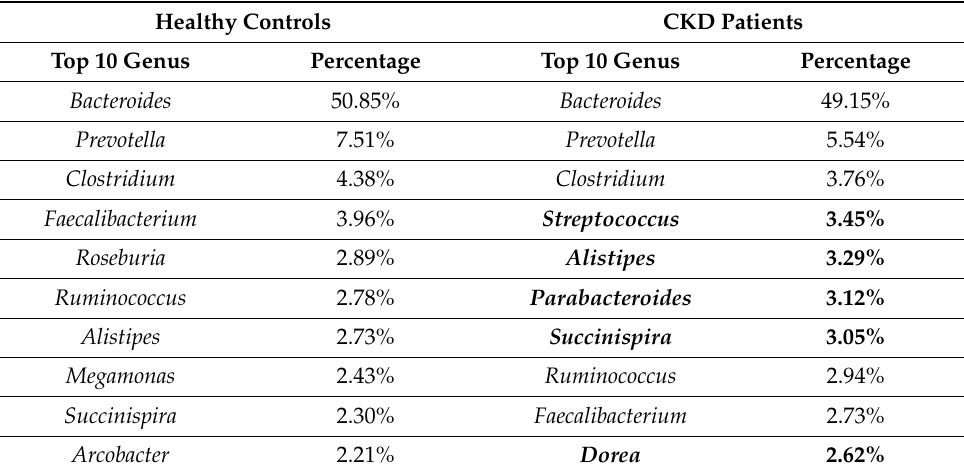
Table 2. Top 10 abundant fecal microbes in healthy controls and ESKD